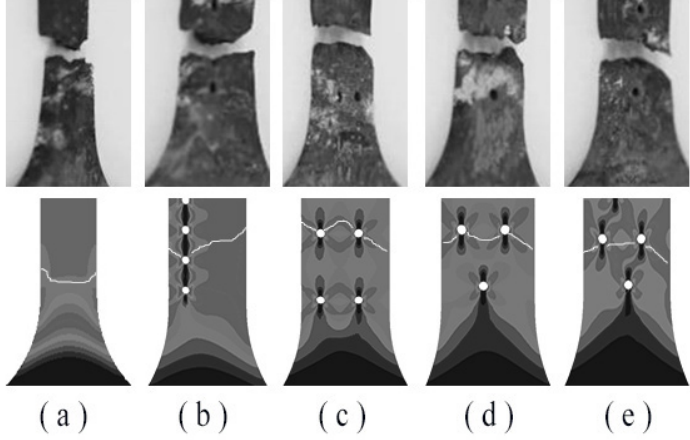
Figure 11. Comparisons between test and numerical results on fracture positions and shapes of specimens with different film-hole configurations: ( a ) zero-row, ( b ) one-row, ( c ) two-row, ( d ) three-row, ( e )